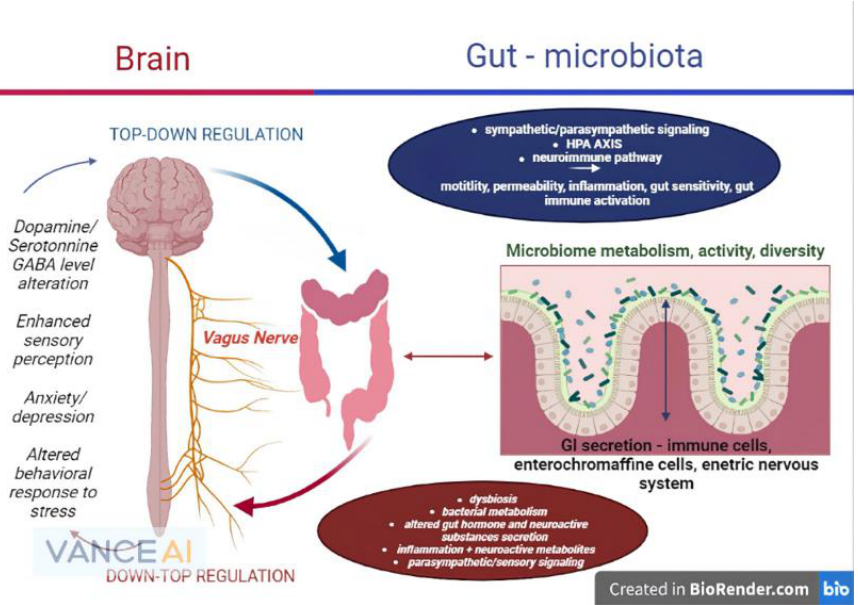
Figure 1. The microbiome – gut – brain axis and its physiopathological interconnections (remake after https://www.frontiersin.org/files/Articles/813204/fmed-09-813204-HTML-r1/image_m/fmed-09-813204-g001.jpg (accessed on 20 September 2022)).